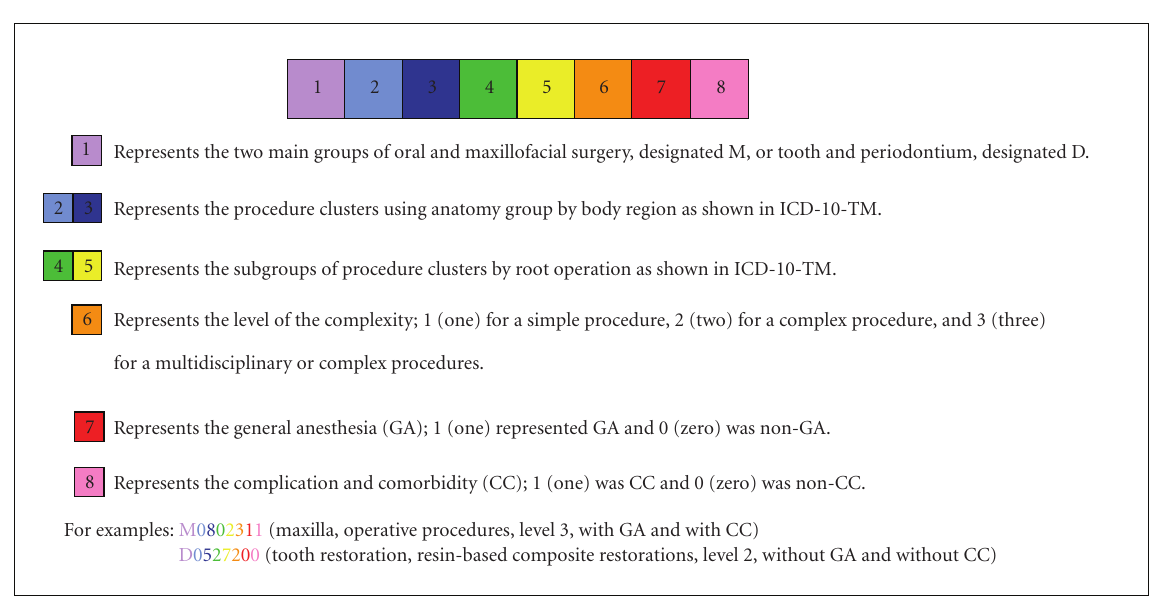
Figure 2: Diagram presents the casemix classification model of OHCS (one procedure in one visit) as represented in eight-digit codes.